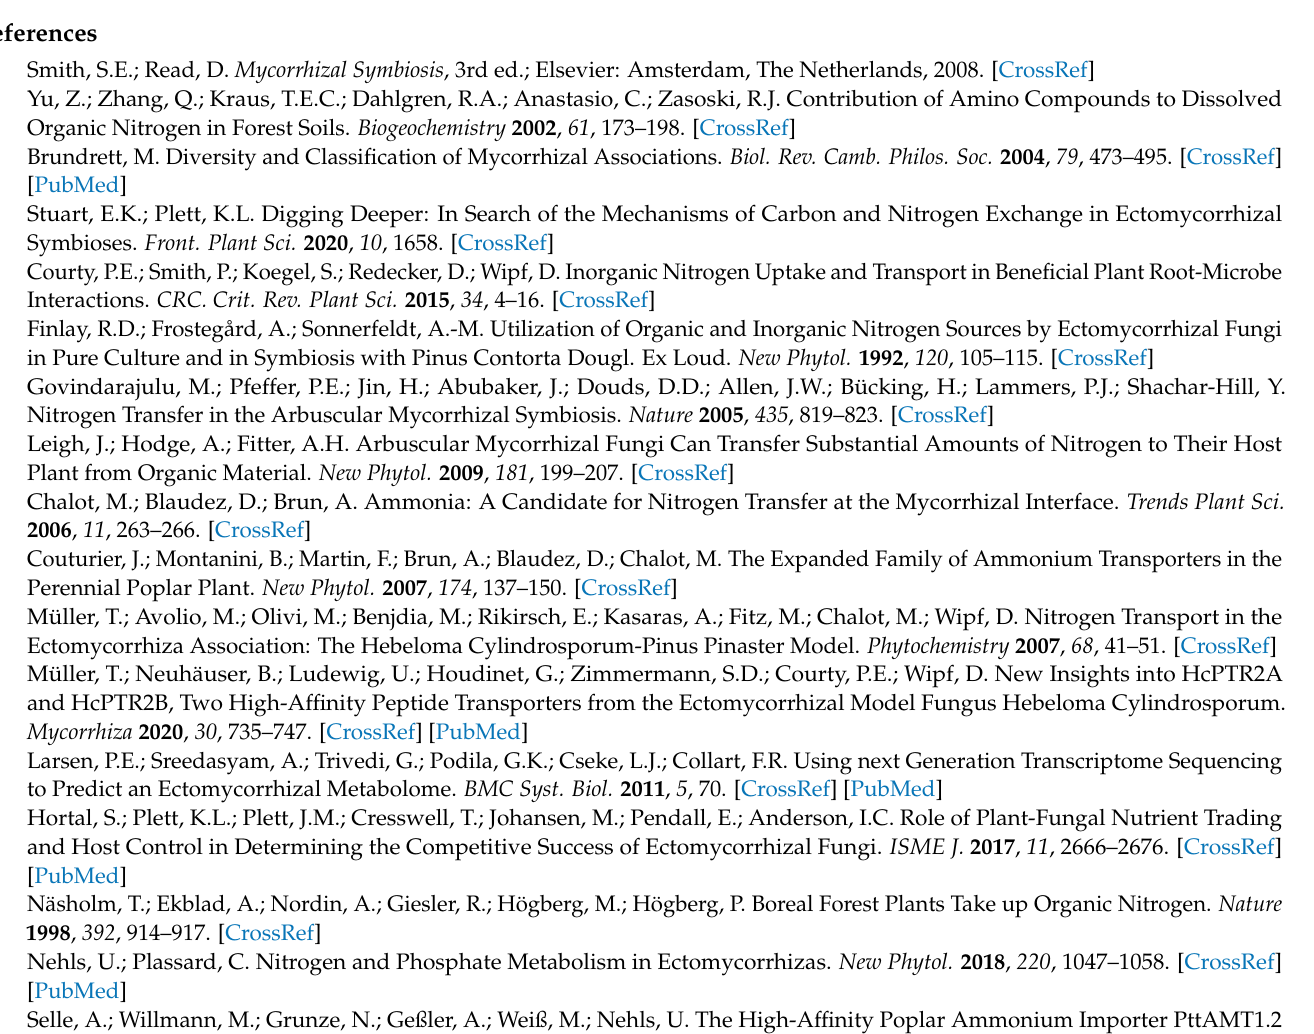
red squares, respectively, following Table 1; Figure S6: Melting curve analysis. Methods S1: Protocol used for the labeled N-uptake